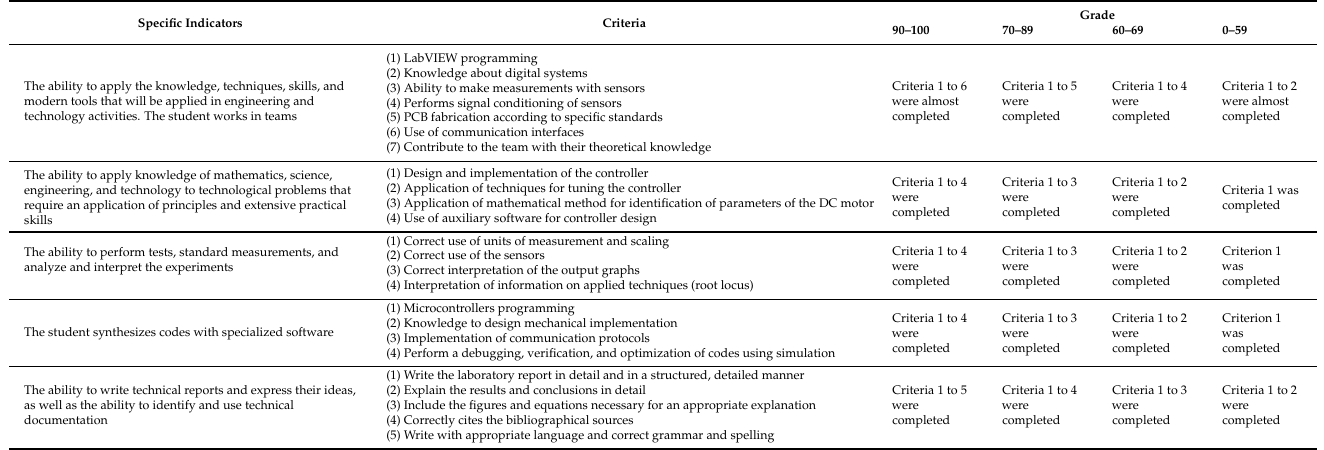
Table 7. The rubric used for evaluating the specific indicators based on